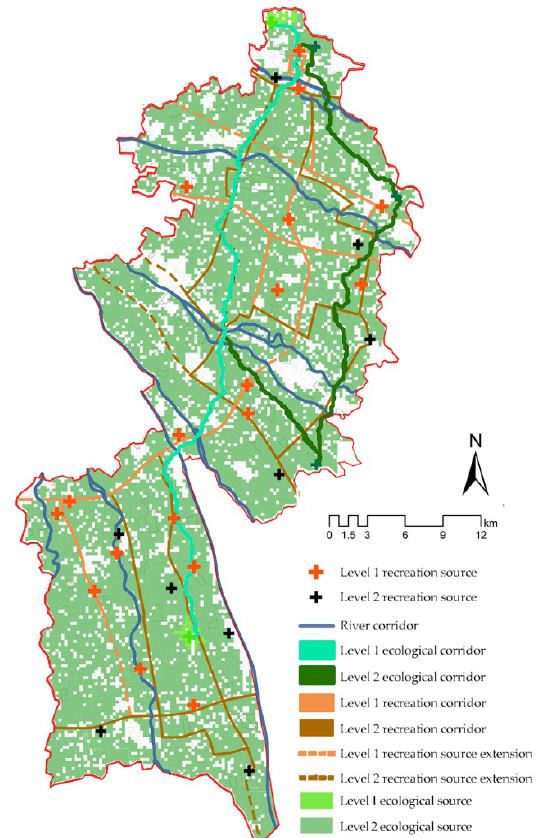
Figure 10. Ecological and recreational security patterns in the Dujiangyan Irrigation District.